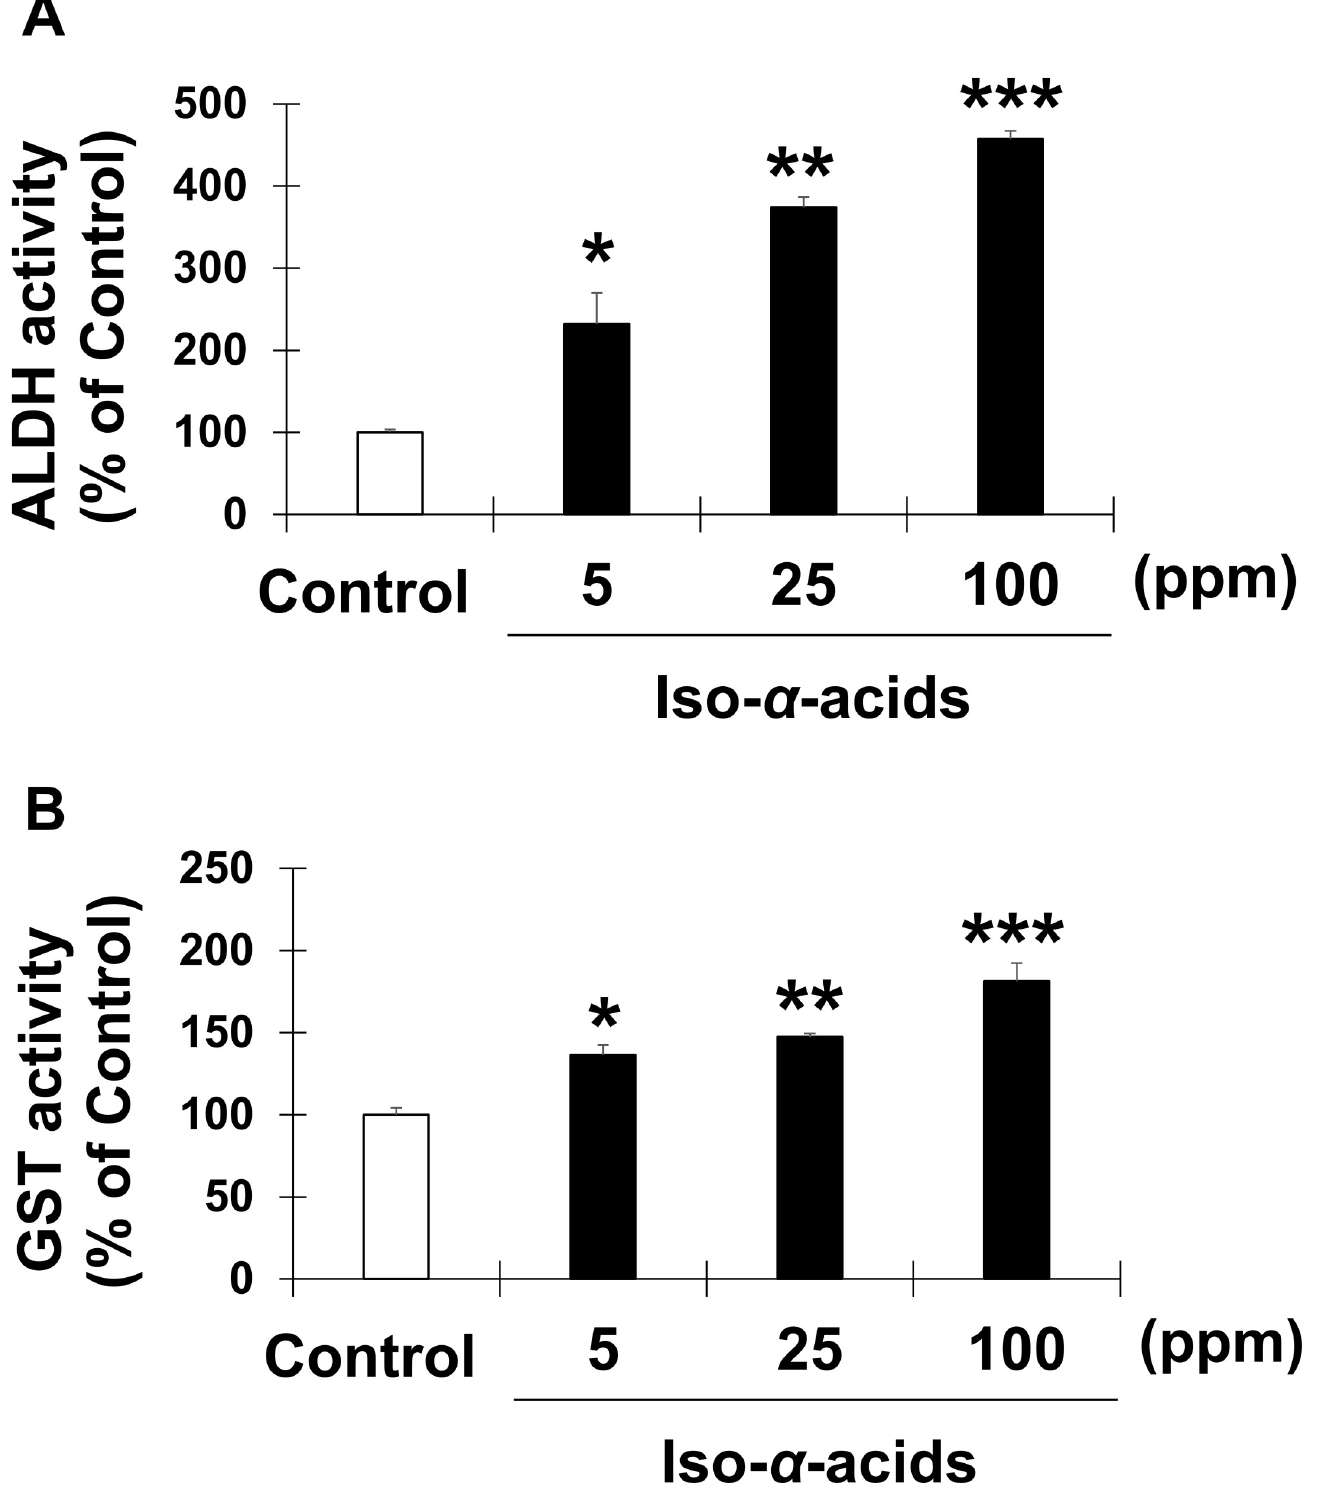
Fig 4. The effect of iso- α -acid treatment on GST and ALDH activity in murine hepatoma cells. Hepa1c1c7 cells were treated with iso- α -acids (5, 25 or 100 ppm) for 48 hours. The GST activity (A) and ALDH activity (B) levels of the cell lysates were examined. Data are shown as the mean ± S.E.M ( n = 3). � p < 0.05, �� p < 0.01, ��� p < 0.001 (vs. the control group).